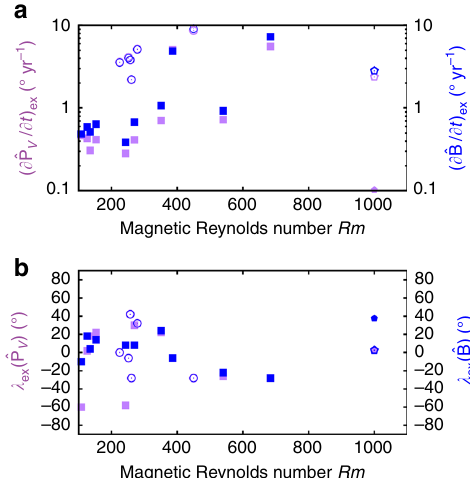
Fig. 2 Amplitudes and locations of extreme directional changes in all simulations and GGF100k. The fi eld vector is denoted ^ B and the VGP position is denoted ^ P V . In b the locations of maximum rates of change of ^ B and ^ P λ ð ^ B Þ and λ ð ^ P Þ , respectively. Closed (open) symbols V are V ex ex indicate non-reversing (reversing) simulations. Where shown, values for Rm = 1000 are averages from the Holocene fi eld model CALS10k.2 10 (solid symbols) and GGF100k 25 (open symbols), otherwise the values plot below the lower limit on the ordinate. All locations are given in degrees.